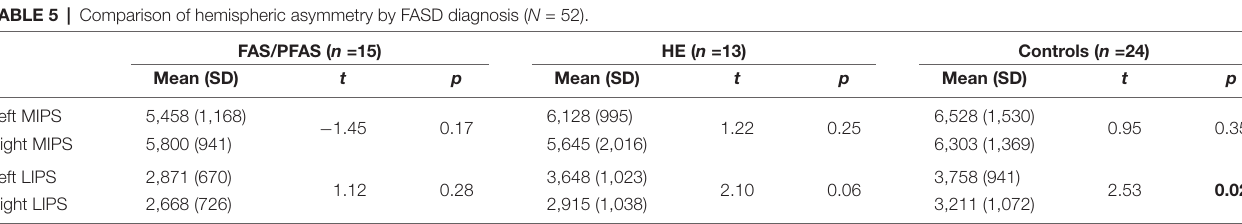
TABLE 5 | Comparison of hemispheric asymmetry by FASD diagnosis ( N = 52).